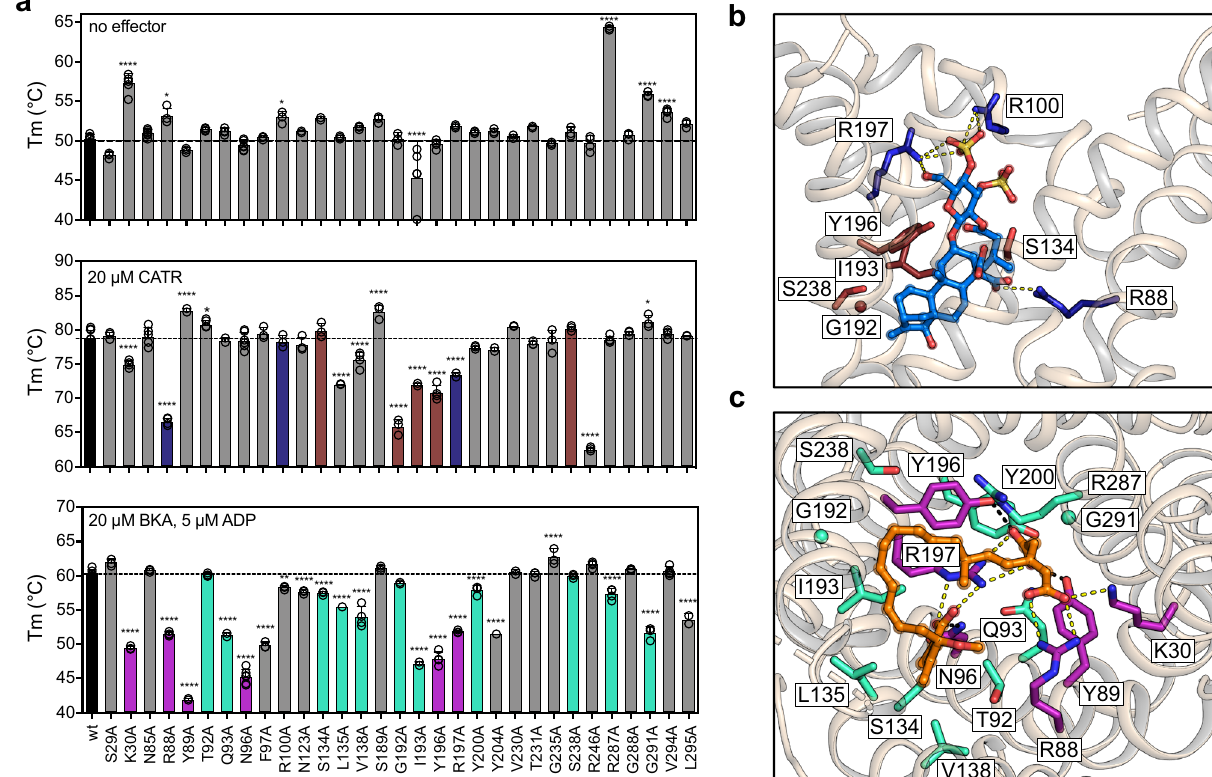
Fig. 3 Mapping the binding sites of the speci fi c inhibitors CATR and BKA. a CPM thermostability data of each protein in absence of effectors (top), or in presence of CATR (middle) or BKA (bottom). The bars and error bars represent the mean and sample standard deviation of eight independent experiments for the wild type and 2 – 7 for the variants. Signi fi cance analysis for each condition was performed with one-way ANOVA, as described in “ Methods ” . Only the signi fi cant are indicated ( p > 0.01, ns; p ≤ 0.01, *; p ≤ 0.001, **; p ≤ 0.0001, ***; p ≤ 0.00001, ****). b Lateral view of ScAac2 cytoplasmic-open state structure in complex with CATR (PDB code: 4c9h chain A). The interacting residues of ScAac2 are conserved in TtAac, with the exception of K104 which is R100 in TtAac and the two proteins share 74% sequence identity. To facilitate comparison, we used the TtAac labelling (Supplementary Fig. 3). Residues that form ionic interactions (yellow dashes) and hydrophobic contacts with CATR (marine) are shown in dark blue and brown, respectively. Residue K104 of ScAac2 has been modelled to Arg (R100) for TtAac. c Matrix view of the matrix-open structure of TtAac with BKA bound (PDB code: 6gci chain A). Residues that form ionic interactions (yellow dashes) or hydrogen bonds (black dashes) with BKA (orange) are shown in purple, while residues that form hydrophobic contacts are shown in cyan. Source data for this fi gure are provided as a Source Data fi